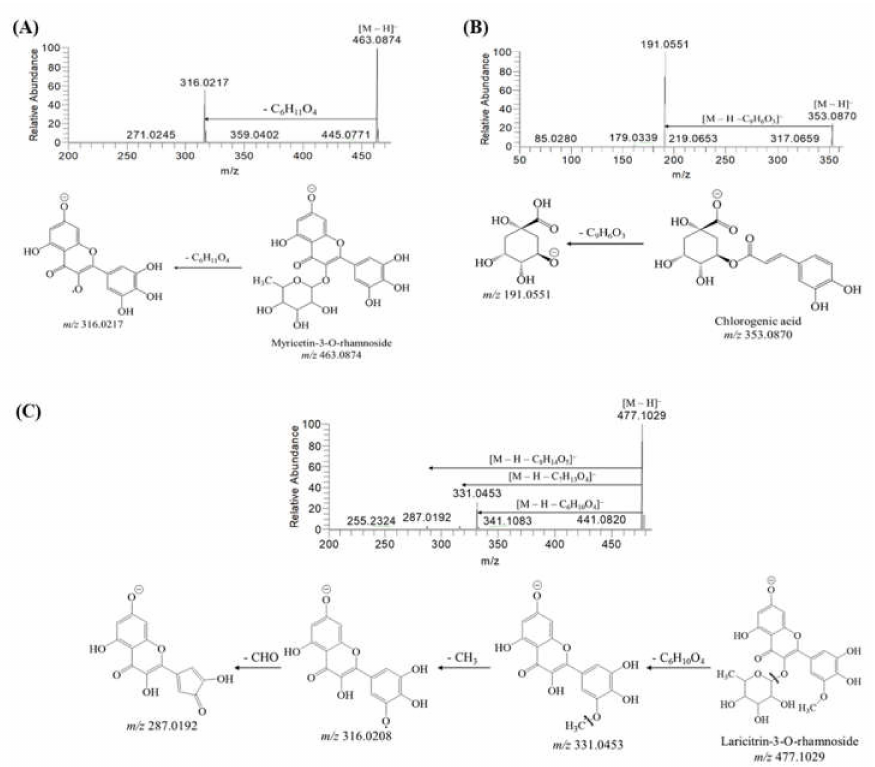
Figure 2. Negative-mode electrospray ionization tandem mass spectrometry (ESI–MS/MS) spectra and schematic fragmentation patterns of ( A ) myricetin-3- O -rhamnoside, ( B ) chlorogenic acid, and ( C ) laricitrin-3- O -rhamnoside; 10–30 eV collision energy (CE) was applied to produce fragmented peaks of the precursor